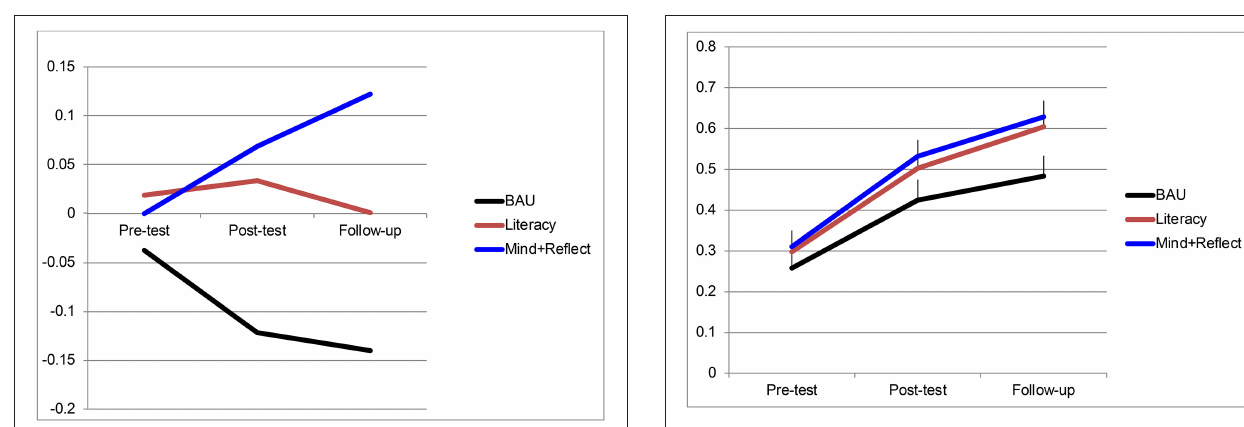
FIGURE 2 | Standard scores ( z ) on the EF composite as a function of time and condition. BAU, Business as Usual; Mind + Reflect, Mindfulness plus Reflection.